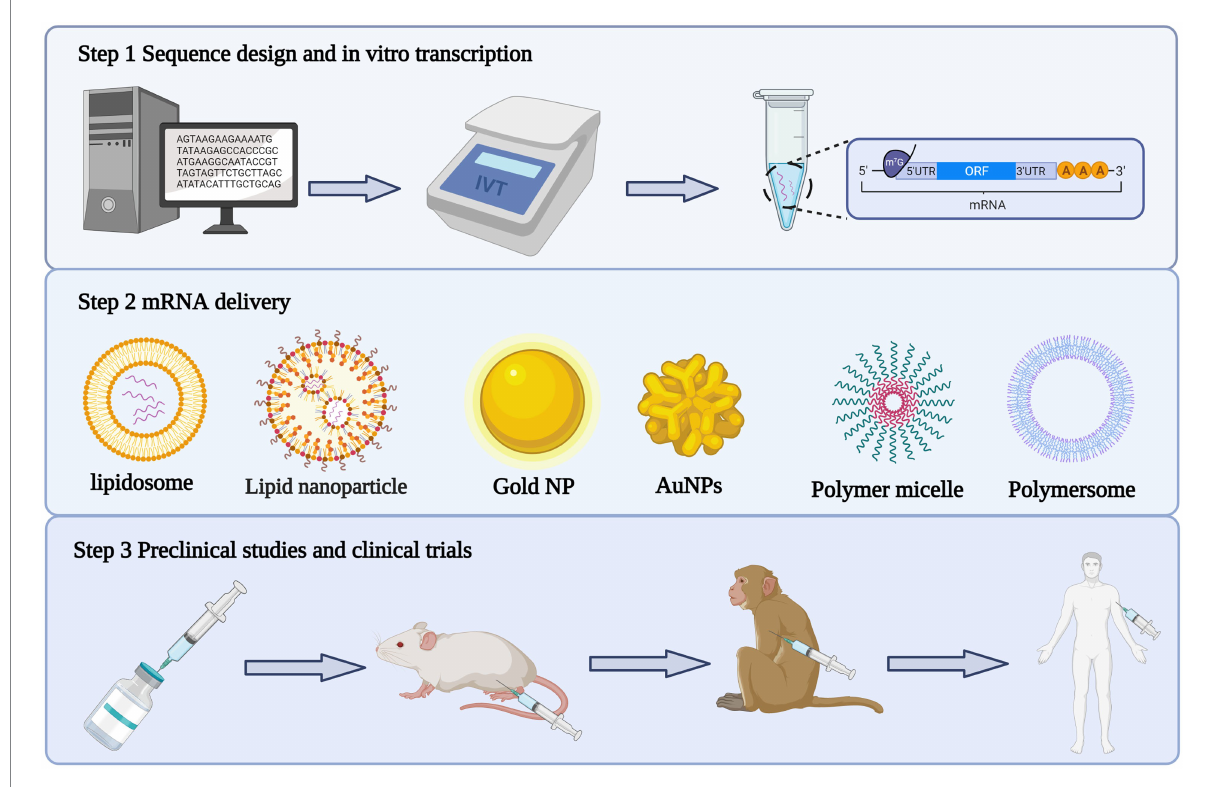
FIGURE 2 Production process of mRNA vaccine. The first step is to design the antigen sequence, construct the plasmid vector, linearize the plasmid and synthesize mRNA through in vitro transcription. The second step is to package the mRNA transcribed in vitro with appropriate delivery system. The third step is to carry out preclinical and clinical trials of the encapsulated mRNA